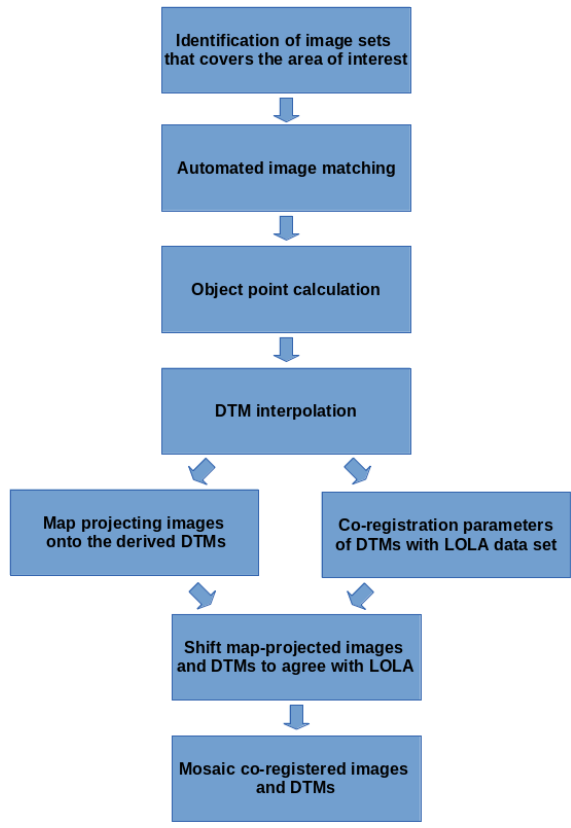
Figure 1: Stereo processing flowchart